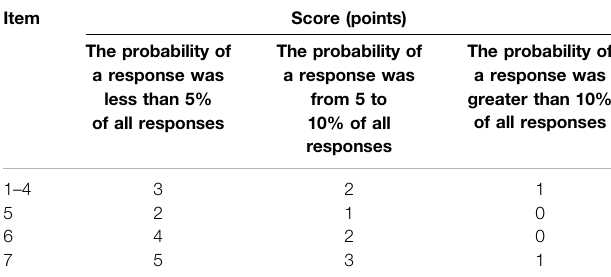
TABLE 3 | De fi nition of scoring for the originality